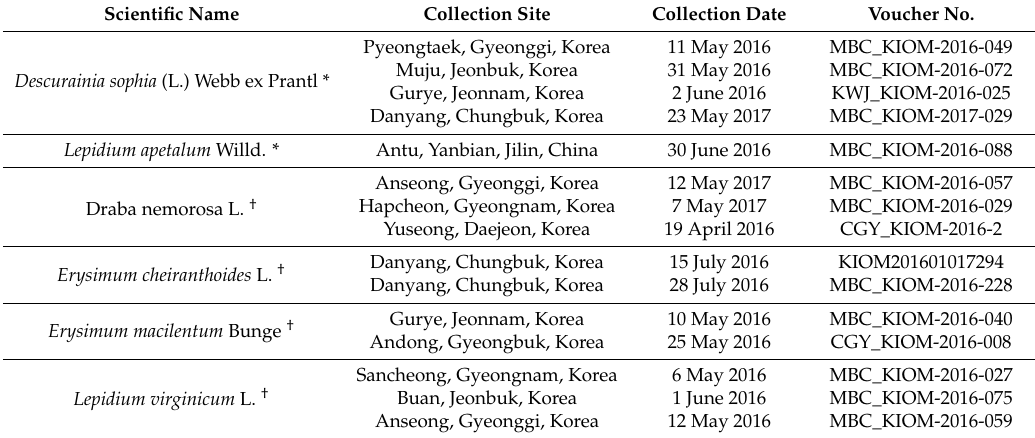
Table 1. List of plant species used in this study along with the collection site, collection date, and voucher number.